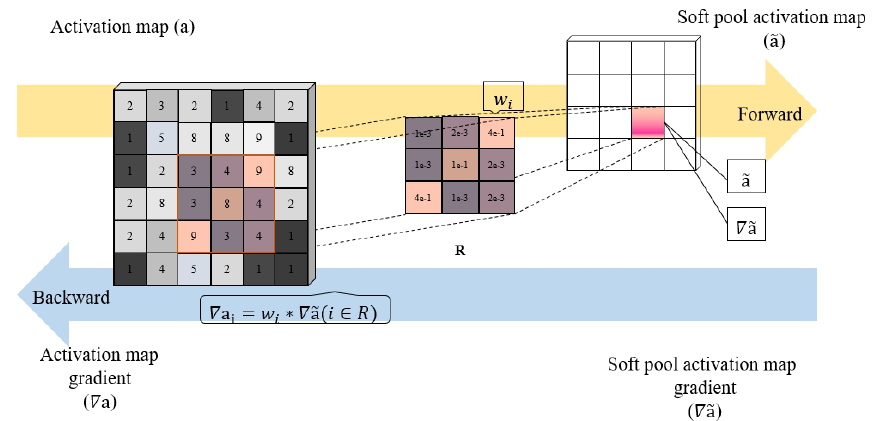
Figure 6. SoftPool schematic.